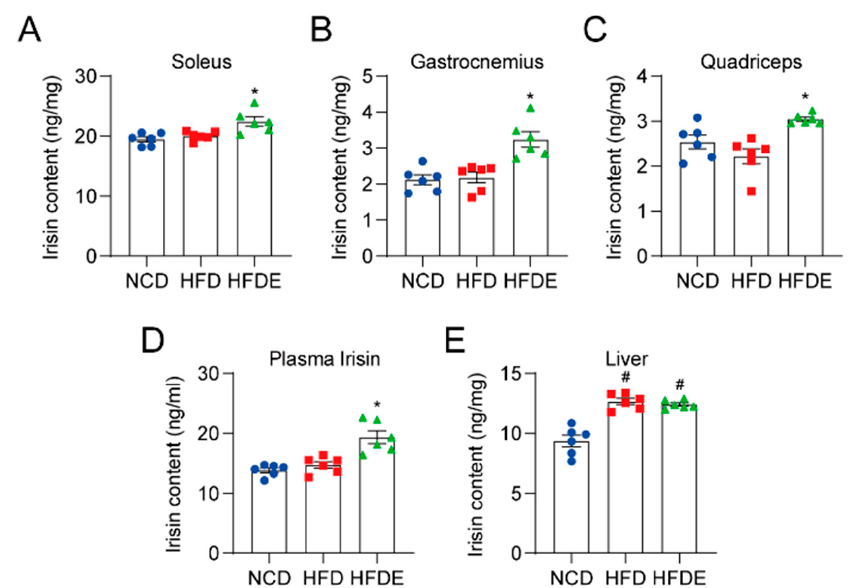
Figure 5. Irisin changes in several tissues and circulating levels. Absolute irisin content in several skeletal muscles including the soleus ( A ), gastrocnemius ( B ), and quadriceps ( C ), circulating levels of irisin ( D ), and absolute hepatic irisin content ( E ) in mice were measured by ELISA. The data are presented as the mean ± SEM, n = 6 per group. # p < 0.05 vs. NCD group; * p < 0.05 vs. HFD group.